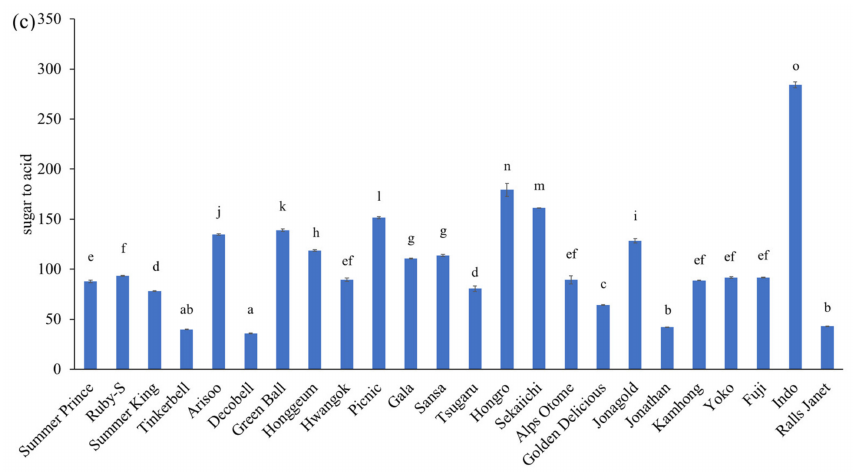
Figure 2. Content of free sugar ( a ), organic acid ( b ), and sugar to acid ratio ( c ) in apple juice made with 24 apple cultivars. Significant di ff erences between cultivars at p < 0.05 are denoted by di ff erent letters. The standard deviation refers to the total amount of sugars and organic